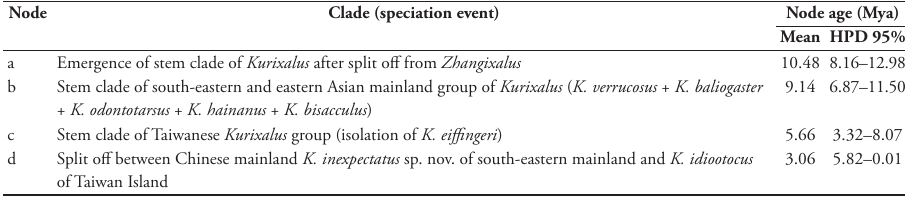
Table 6. Molecular dating of 16 species of Asian rhacophorid frogs estimates the age of lineage separa- tion between K. inexpectatus sp. nov. and K. idiootocus . The molecular dating estimation was using an uncorrelated lognormal relaxed clock with Yule prior on species tree inferred from unlinked 12S rRNA and TYR gene fragments of Kurixalus and rhacophorid taxa ( n taxa = 79) distributed across Southeast Asia and East